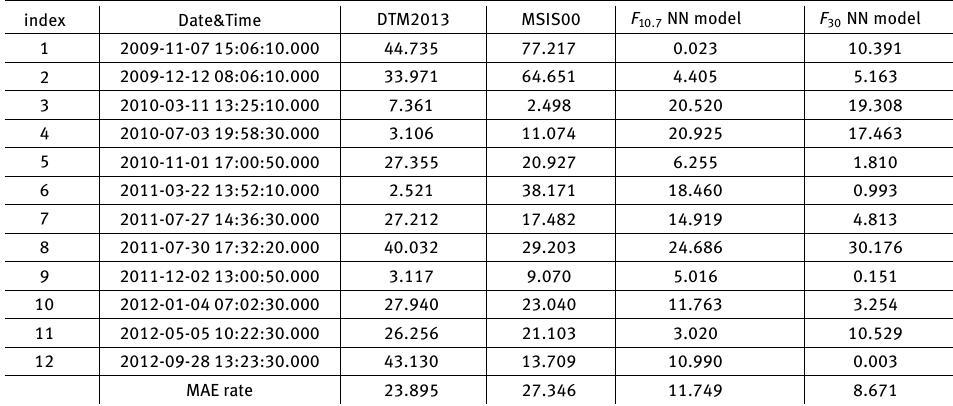
Table 3. MAE rates statistics of atmospheric density simulation of the four